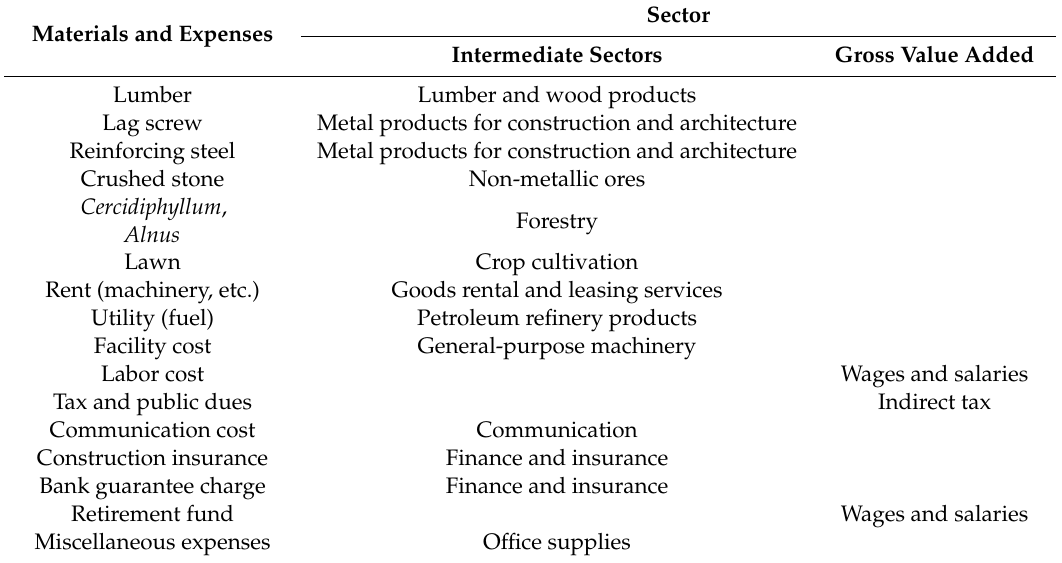
Table 2. Timber check dam: Assignment of materials and expenses to sectors.